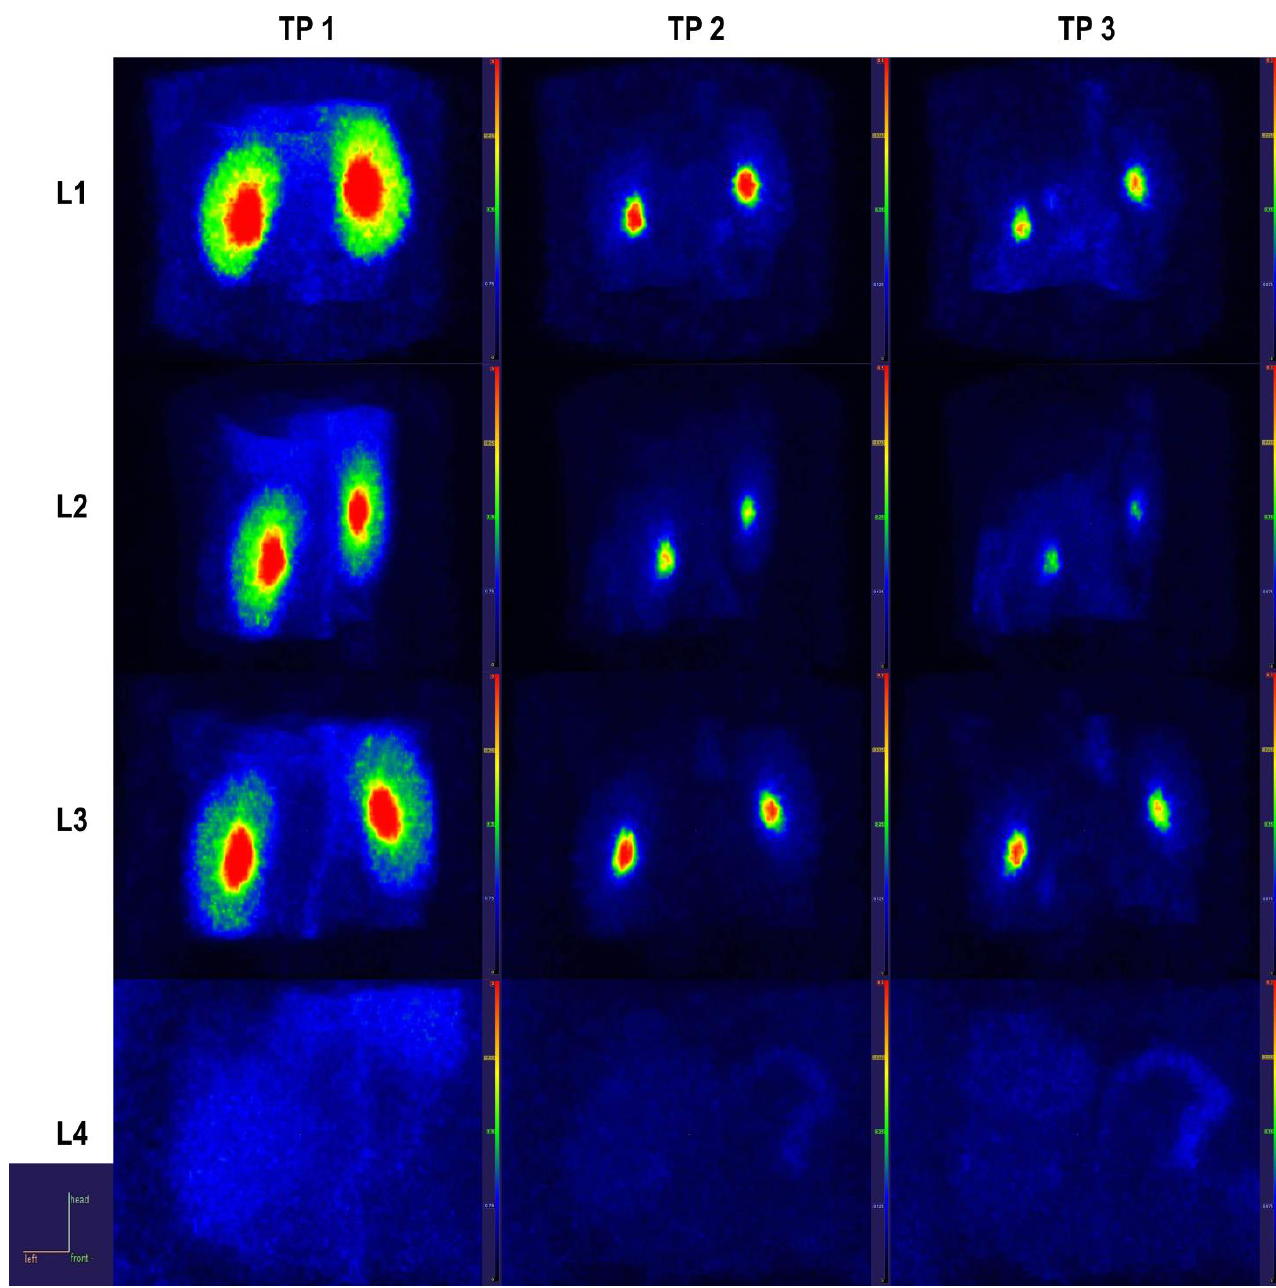
Figure 8. Renal close-ups in parametric maximal intensity projection images with voxel-wise nor- malization to blood SUV, depicting different behaviors of 18 F-FDG according to time interval and